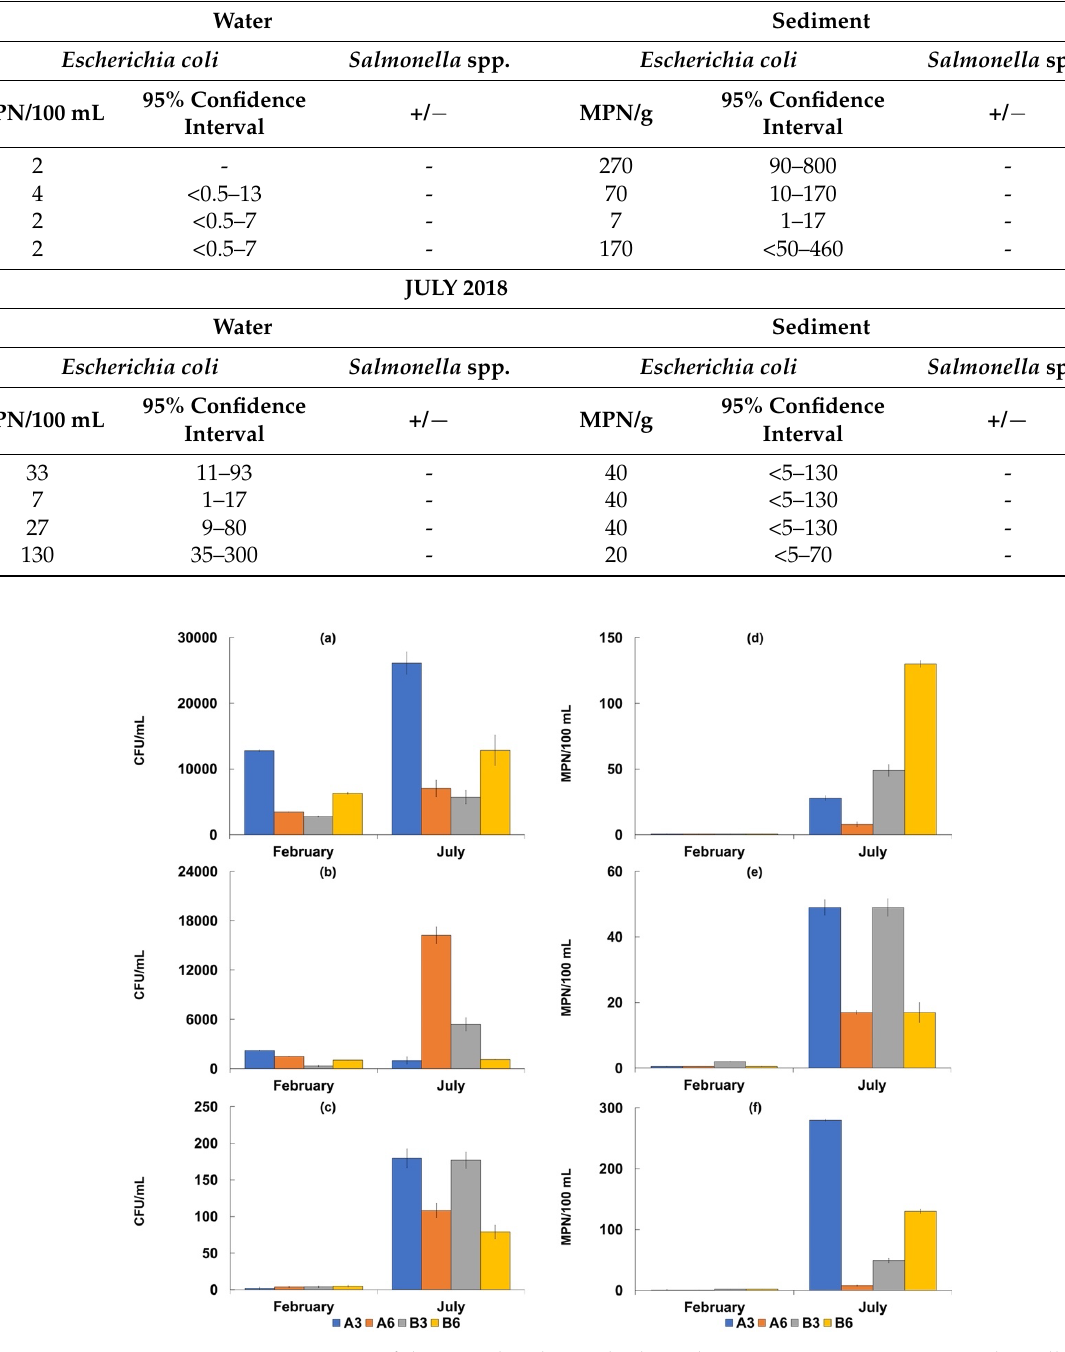
Figure 2. Concentrations of the considered microbiological parameters in seawater samples collected in February and July 2018 at the four sampling sites (A3, A6, B3 and B6). Bacterial counts are reported as mean values ± S.D. of three replicates. Bacterial counts are expressed as CFU/mL for culturable heterotrophic bacteria at 22 °C ( a ), culturable bacteria at 37 °C ( b ) and culturable vibrios ( c ), and as MPN/100 mL for fecal coliforms ( d ), fecal enterococci ( e ), and total coliforms ( f ).